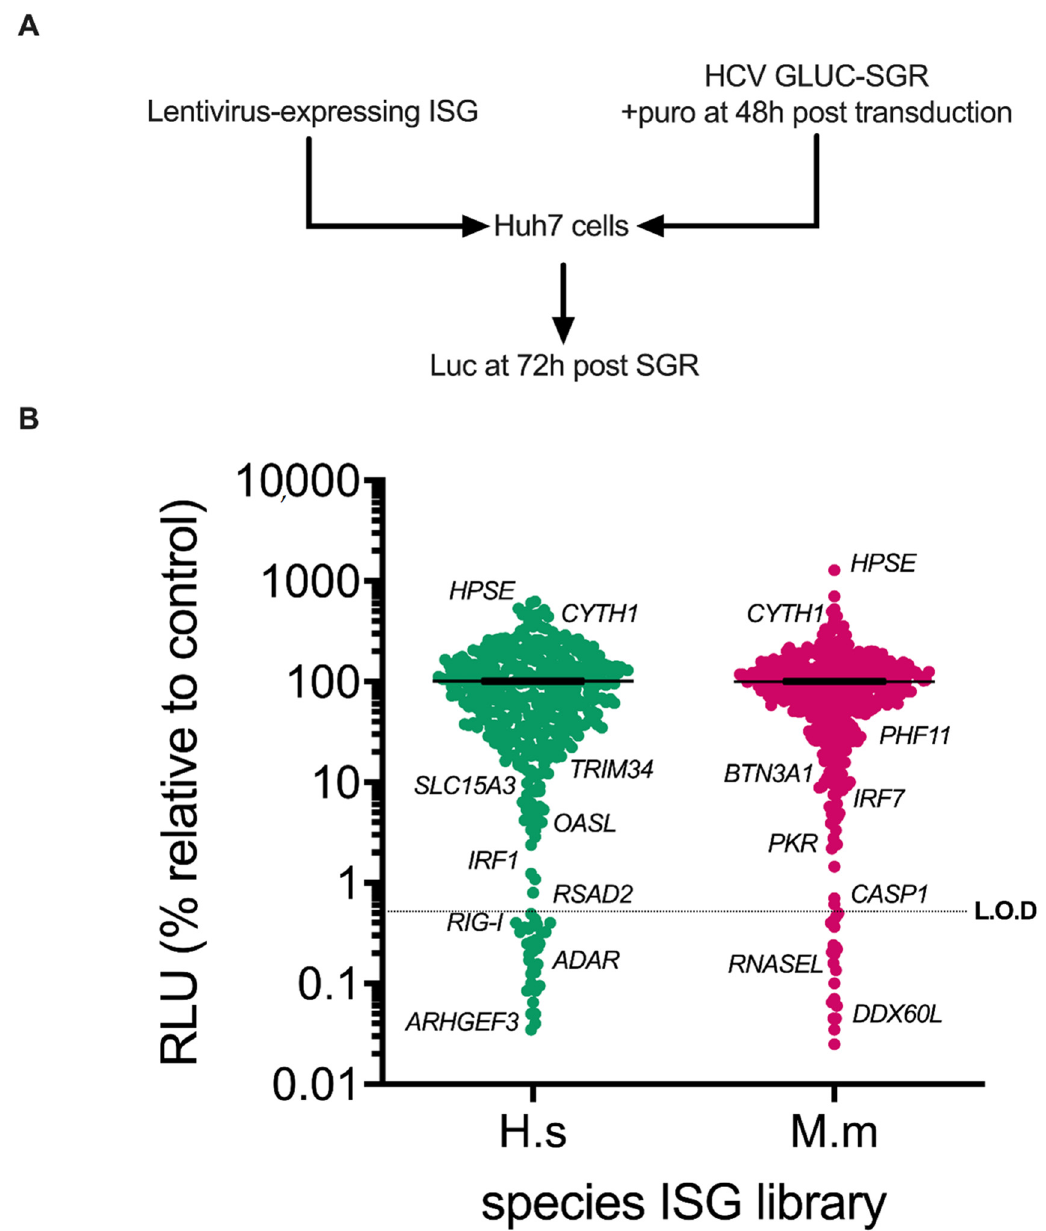
Figure 1. Screening for ISGs from humans and rhesus macaques that influence HCV-SGR luciferase reporter activity. ( A ) Schematic depiction of the screening protocol used in the study showing that Huh7 cells were transduced and transfected with luciferase-expressing HCV SGR after 48 h and the secreted luciferase levels were quantified at 72 h post-transfection (hpt). ( B ) Dot plot of RLU detected for ISG-expressing cells transfected with HCV-SGR RNA for human (Hs; green) and rhesus macaque (Mm; red) ISGs, relative to the control ISGs (%) from 72 hpt. The primary screen was performed as single assays. Genes of interest are marked on the figure. Limit of detection (L.O.D) highlighted with a dotted line.